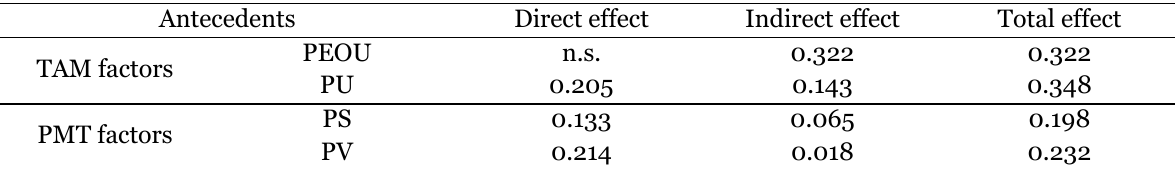
Antecedents ’ Effect on